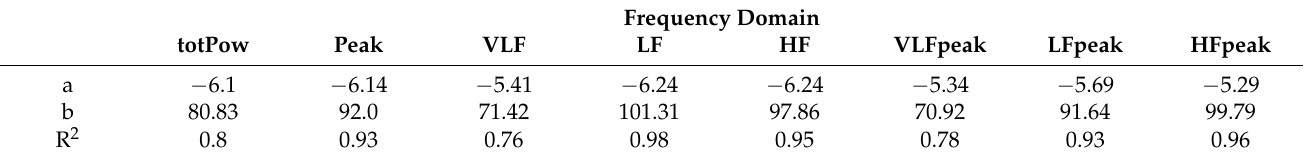
Table A2. Wilcoxon Rank Sum Test—Linear Regressions of the Statistical Percentages (subpart 2).